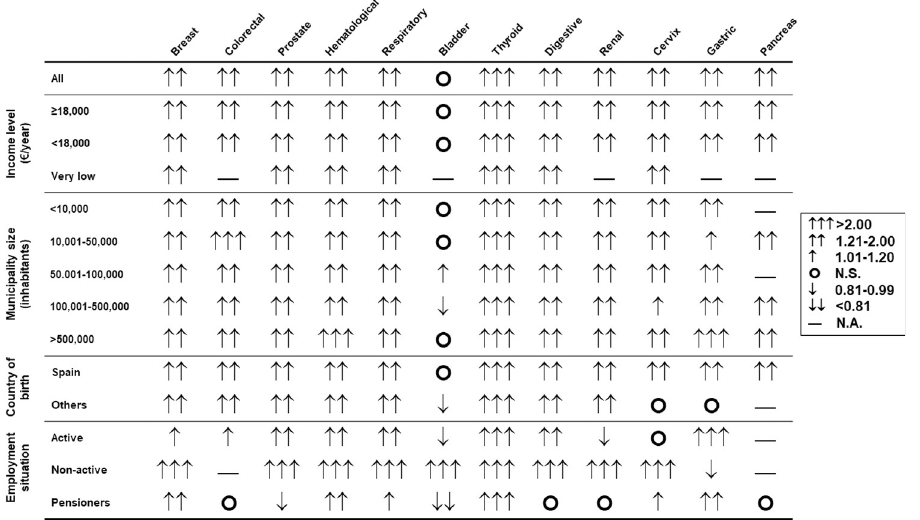
Fig 1. Relative risk (OR) of the different malignancies studied in patients with hypothyroidism classified according to sociodemographic variables. Arrows are used to indicate a statistically significant OR value greater than ( " ) or less than 1 ( # ). The circle ( ^ ) indicates a non-significant OR value (N.S.). The dash (—) is used to represent data not available